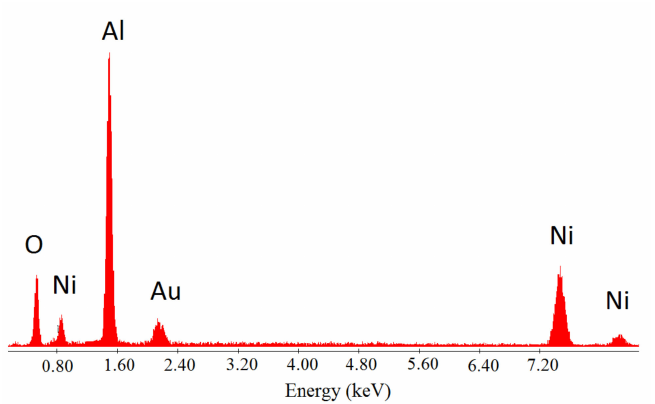
Figure 11. Chemical analysis of the 34.4% NiO—45.6% Al—20% Al 2 O 3 catalyst. Thus, NiO–Al- α -Al 2 O 3 catalysts with various element ratios were synthesized, their combustion characteristics, composition, and structure of the resulting catalysts, and their specific surface were